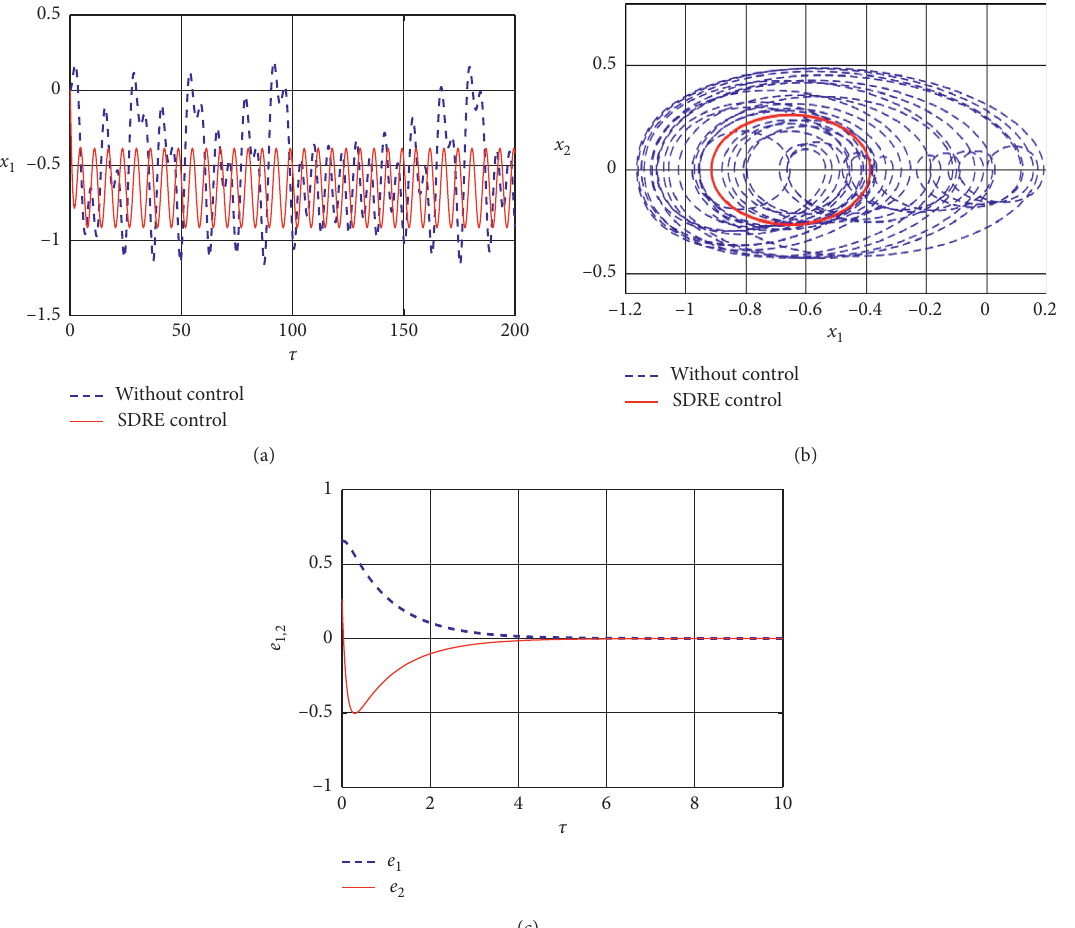
� x − 􏽥 x � x − 􏽥 x and e . 1 1 1 2 2 2